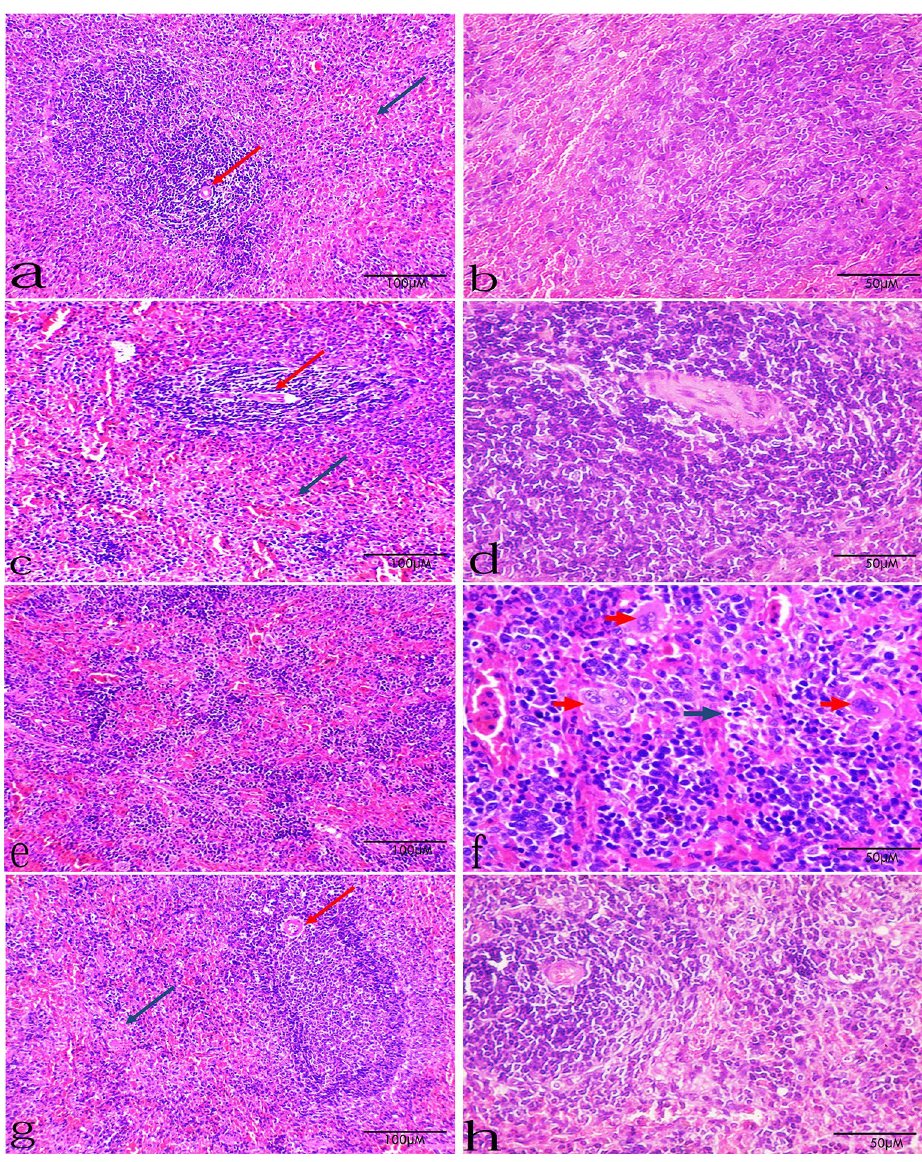
Figure 6. Group I ( a , b ): Splenic tissue in a control rat showing normal architecture with normal red pulp (blue arrow) and white pulp with central arteriole (red arrow). Group II ( c , d ): Splenic tissue in a control rat treated by FUC showing normal architecture with normal red pulp (blue arrow) and white pulp with central arteriole (red arrow). Group III ( e , f ): Splenic tissue in a splenic dysfunction rat showing disturbed architecture in the form of irregular white pulp and congested red pulp. Its higher magnification showing red pulp with extramedullary hematopoiesis with many megakaryocytes (red arrows) and apoptotic bodies (blue arrow). Group IV ( g , h ): Splenic tissue in a splenic dysfunction treated by FUC rat showing preserved architecture with clearly defined red pulp (blue arrow) and white pulp with central arteriole (red arrow). The left panel is with low magnification: ×200, scale bar 100 μm. and the right panel is with high magnification: ×400, scale bar 50